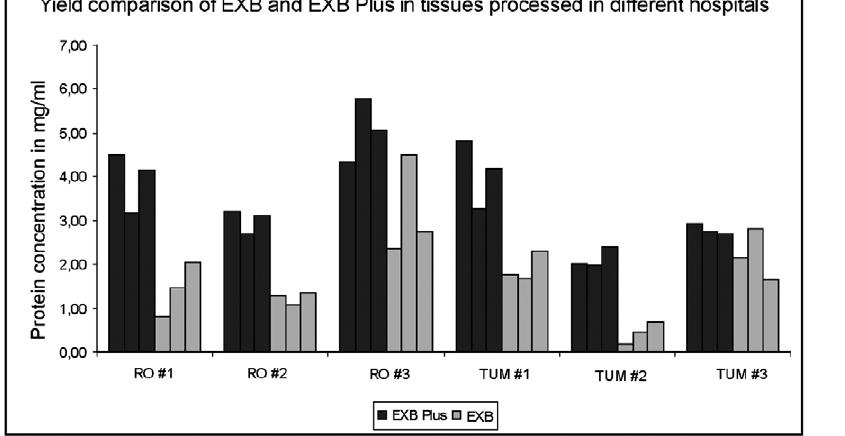
Figure 2. Protein amounts gained by extraction from FFPE tissues from two different hospitals in three technical replicates. EXB Plus allowed high protein yields independently of the tumor sample or the hospital the tissue was processed in. Additionally only minimal variations between the replicates (mean standard deviation: 0.47 mg/ml) could be detected.